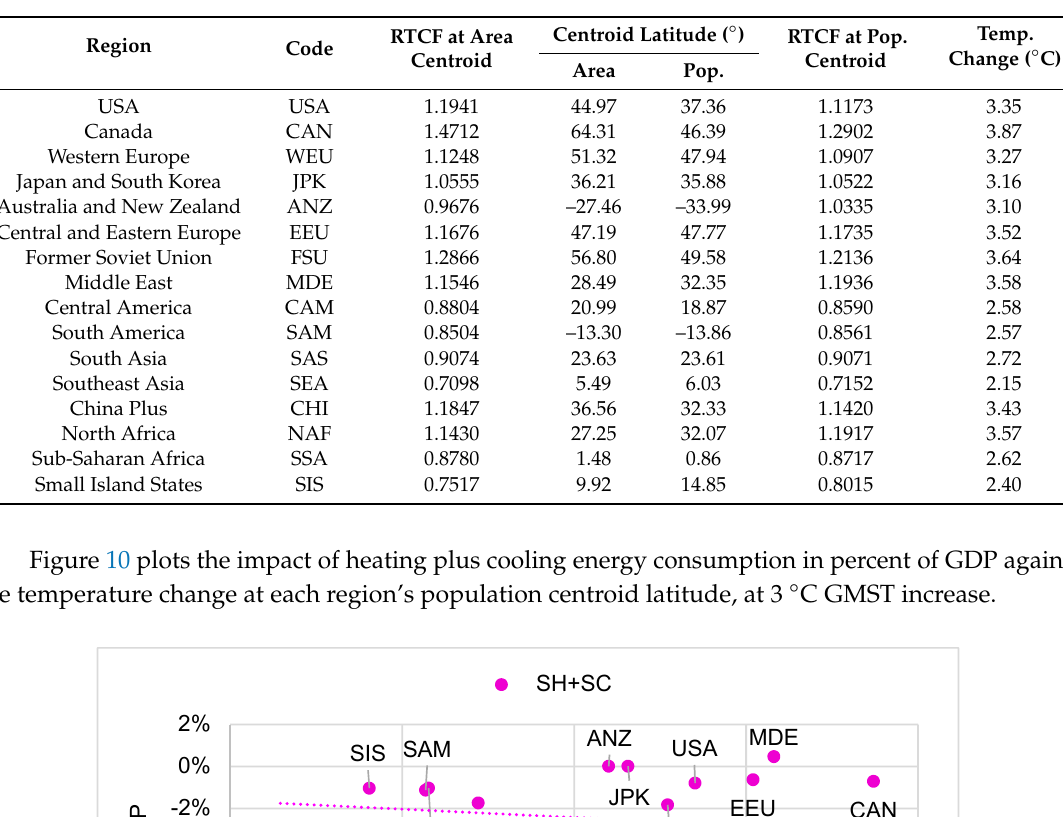
Table 3. Area and population RTCFs, their latitudes, and temperature change at the population centroid latitude at 3 ◦ C GMST increase, by region.